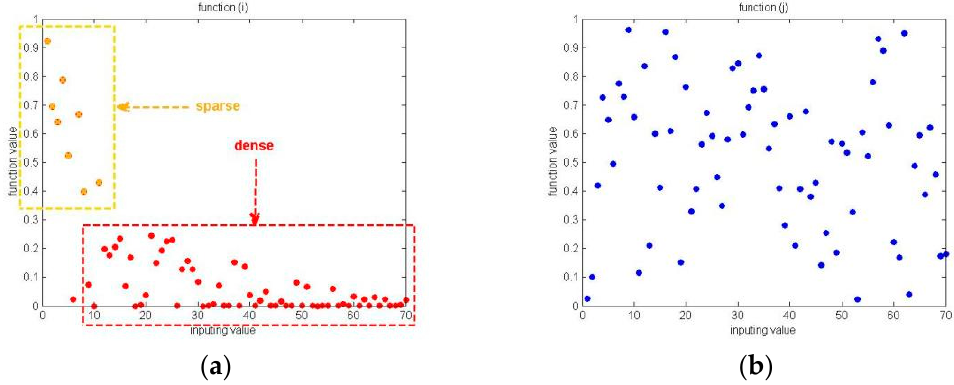
Figure 2. The searching result figures based on Equations (11) and (12). ( a ) searching processes based on Equation (11); ( b ) searching processes based on Equation (12).